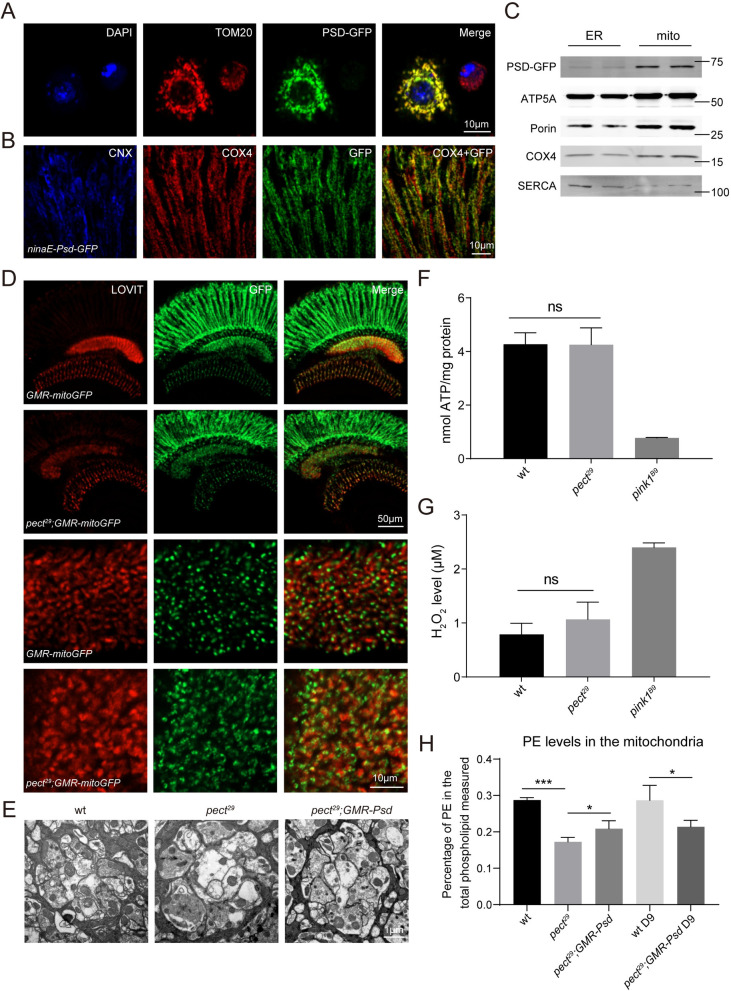
PECT is not required for mitochondria localization or activity.(A-B) Subcellular localization of PSD in (A) S2 cells and (B) adult eyes. (A) S2 cells were transiently transfected with psd-GFP and labeled with antibodies against TOM20 (red). Scale bar is 10 μm. (B) Cryostat sections from ninaE-Psd-GFP flies were labeled with antibodies against Calnexin (blue), COX4 (red), and GFP (green). Scale bar is 10 μm. (C) Western blot analysis of fractionated ER and mitochondria from ninaE-Psd-GFP flies that were labeled with antibodies against GFP, ATP5A, Porin, COX4, and SERCA. (D) Cryostat sections from GMR-mitoGFP and pect29;GMR-mitoGFP (ey-flp rh1-GFP;pect29
FRT40A/GMR-hid CL FRT40A;GMR-mitoGFP/+) flies were labeled with antibodies against LOVIT (red) and GFP (green). The longitudinal views of the visual system were shown in upper panels and the higher magnification of lamina regions were shown in lower panels. Scale bars are 50 μm or 10 μm in upper and lower panels, respectively. (E) TEM micrographs of cartridges containing wild type, pect29, and pect29;GMR-Psd terminals, respectively. Scale bar is 1 μm. (F) Rates of ATP synthesis from the dissected fly retinas of indicated genotypes. Data are presented as mean ± SD, ns, not significant (Student’s unpaired t-test). n = 3. (G) The hydrogen peroxide levels detected in the dissected fly retinas from different genotypes. Data are presented as mean ± SD, ns, not significant (Student’s unpaired t-test). n = 3. (H) Lipidomic analysis of mitochondria isolated from dissected retinas of wt, pect29, and pect29;GMR-Psd flies at indicated time points. PE levels expressed in molar fractions are normalized to total phospholipids. Data are presented as mean ± SD, *p < 0.05, ***p < 0.001 (Student’s unpaired t-test). n = 4.